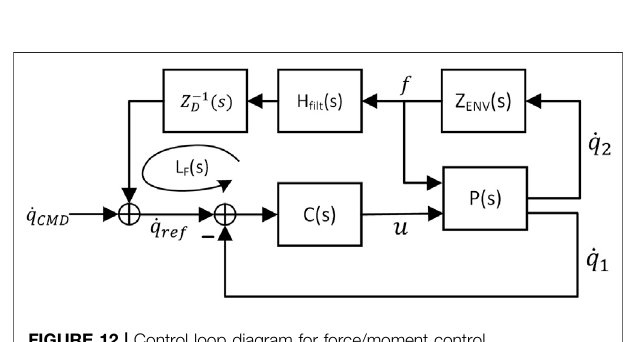
FIGURE 12 | Control loop diagram for force/moment